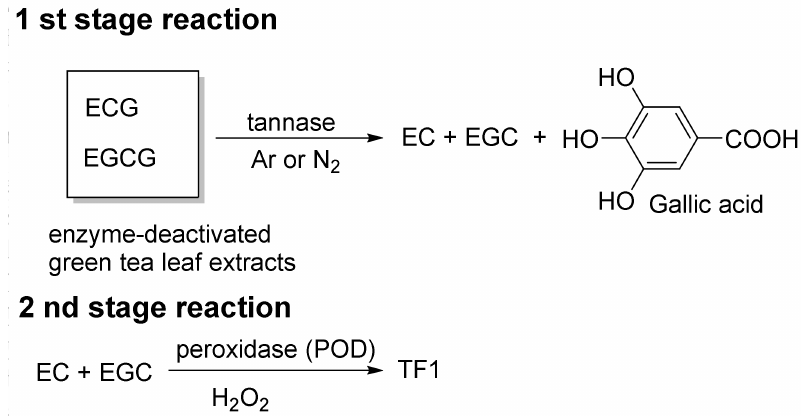
Figure 5. The William method of TF1